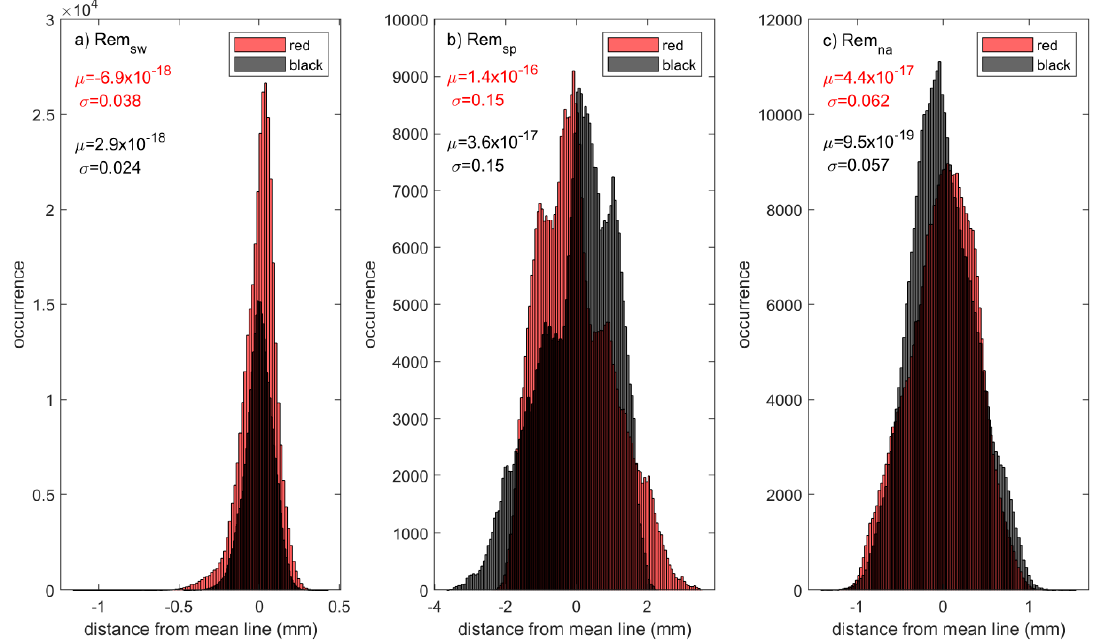
Figure 8. Statistical distribution of the relative heights to the mean plane for the separate specimen halves (red and black). ( a ) sawed specimen; ( b ) split specimen; ( c ) natural fractured specimen. The natural fracture shows anisotropy in the flow direction and vertical to it for almost all surface roughness measures. As an example, the skewness of the relative height distribution of the surfaces is obtained as 0.49 in the flow and 0.24 in x direction. The kurtosis of the relative height